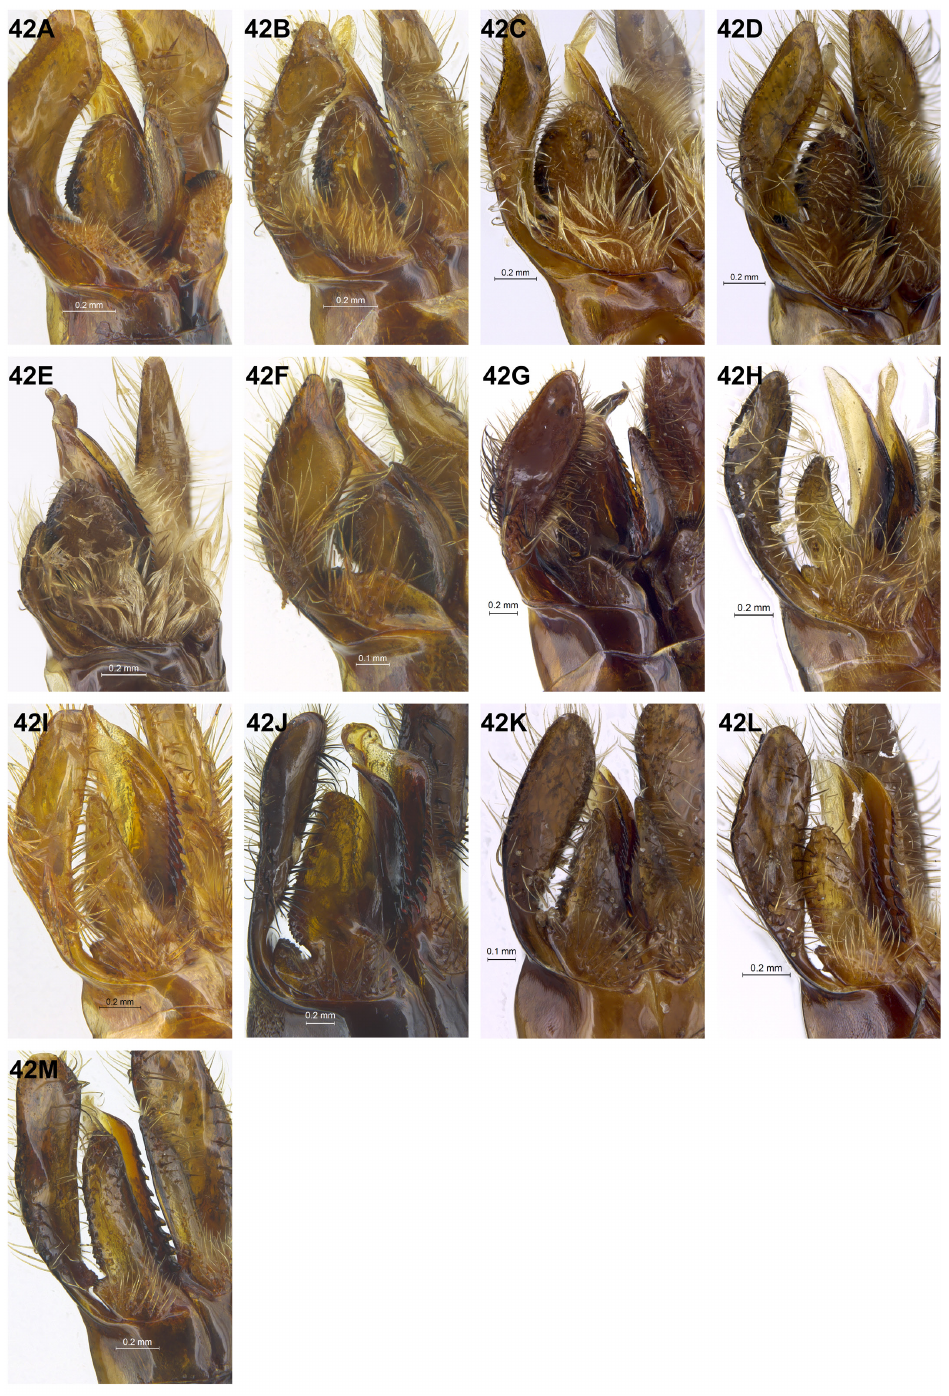
Fig. 42. Males genital capsule, ¾ view ventral side. A . Campsomeriella annulata annulata